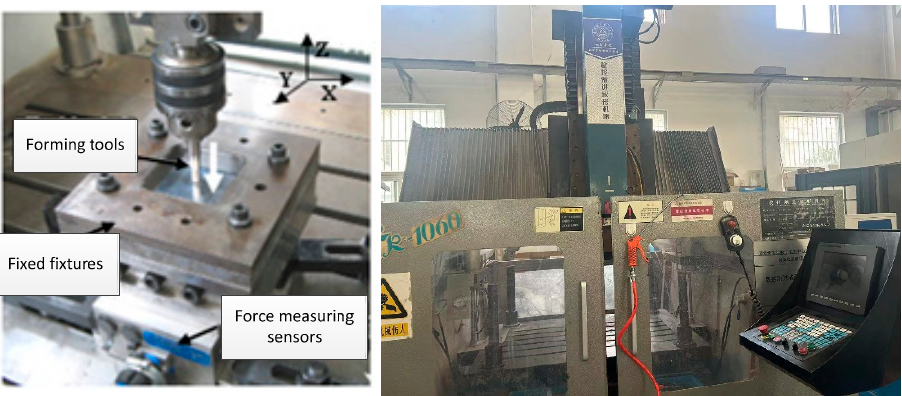
Figure 7. Measurement diagram of the deformation force.